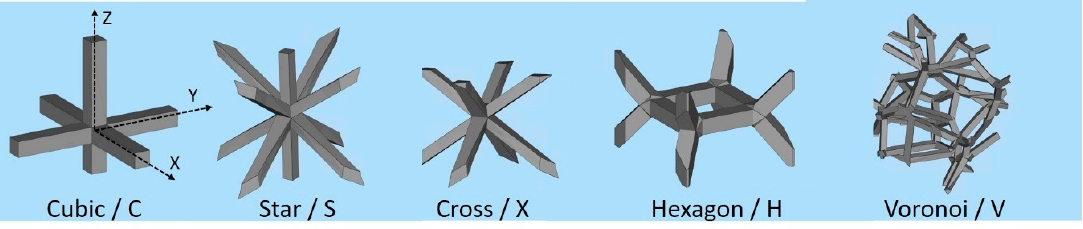
Figure 1. The five base architectures investigated.